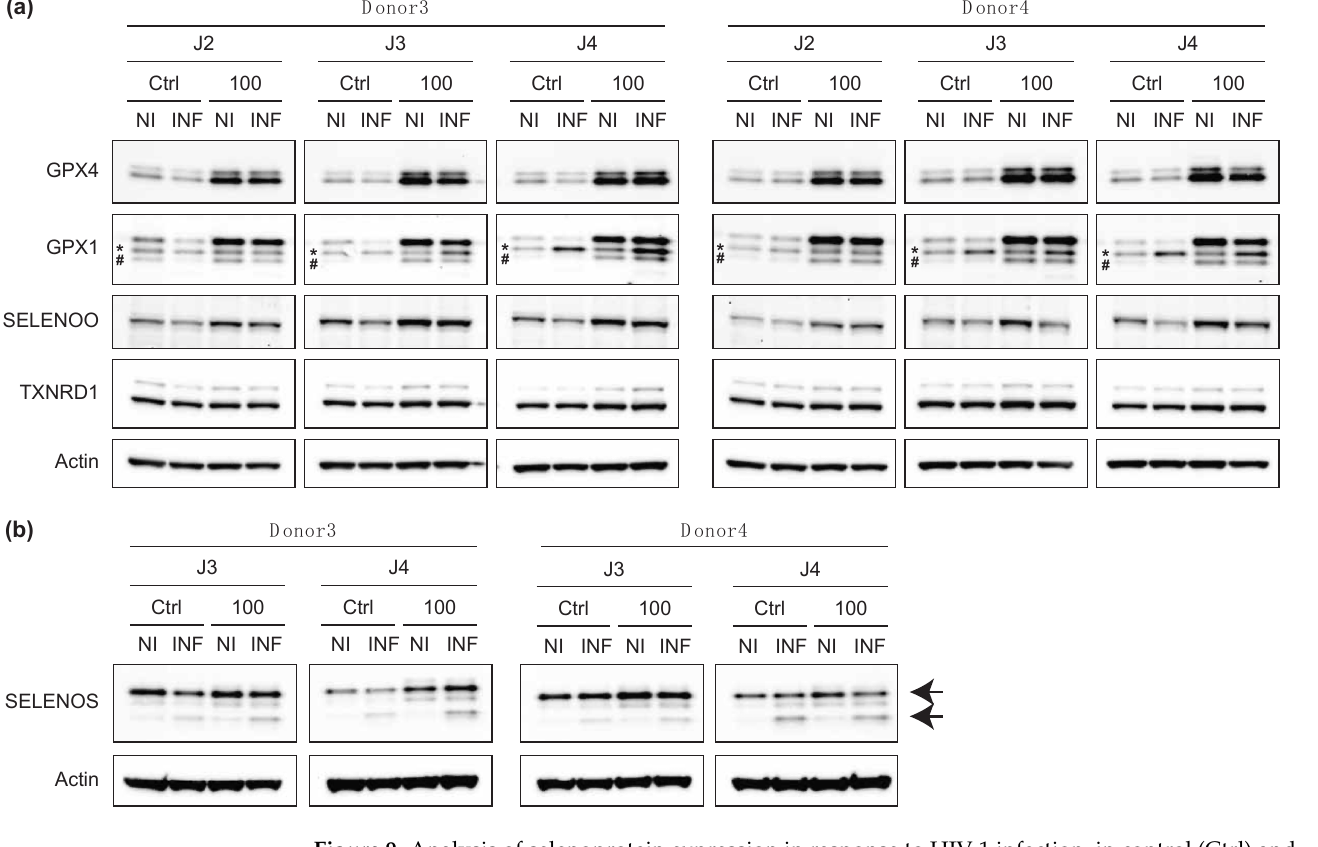
Figure 9. Analysis of selenoprotein expression in response to HIV-1 infection, in control (Ctrl) and 100 nM supplemented conditions. NI, non-infected cell extracts; INF, infected cell extracts. Donor 3 and Donor 4 were analyzed ( n = 1) for the expression of SELENOO, GPX1, GPX4 and TXNRD1 ( a ) and SELENOS ( b ). Non-specific bands are indicated by an asterisk. The hash indicates an unknown band for GPX1. The arrows indicate the migration of two isoforms for SELENOS. The values are given in Table